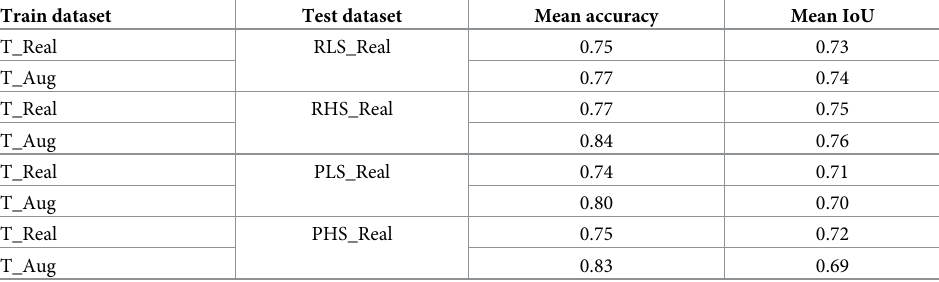
Table 6. Semantic segmentation results using a training dataset of real underwater sonar images and synthetic underwater sonar